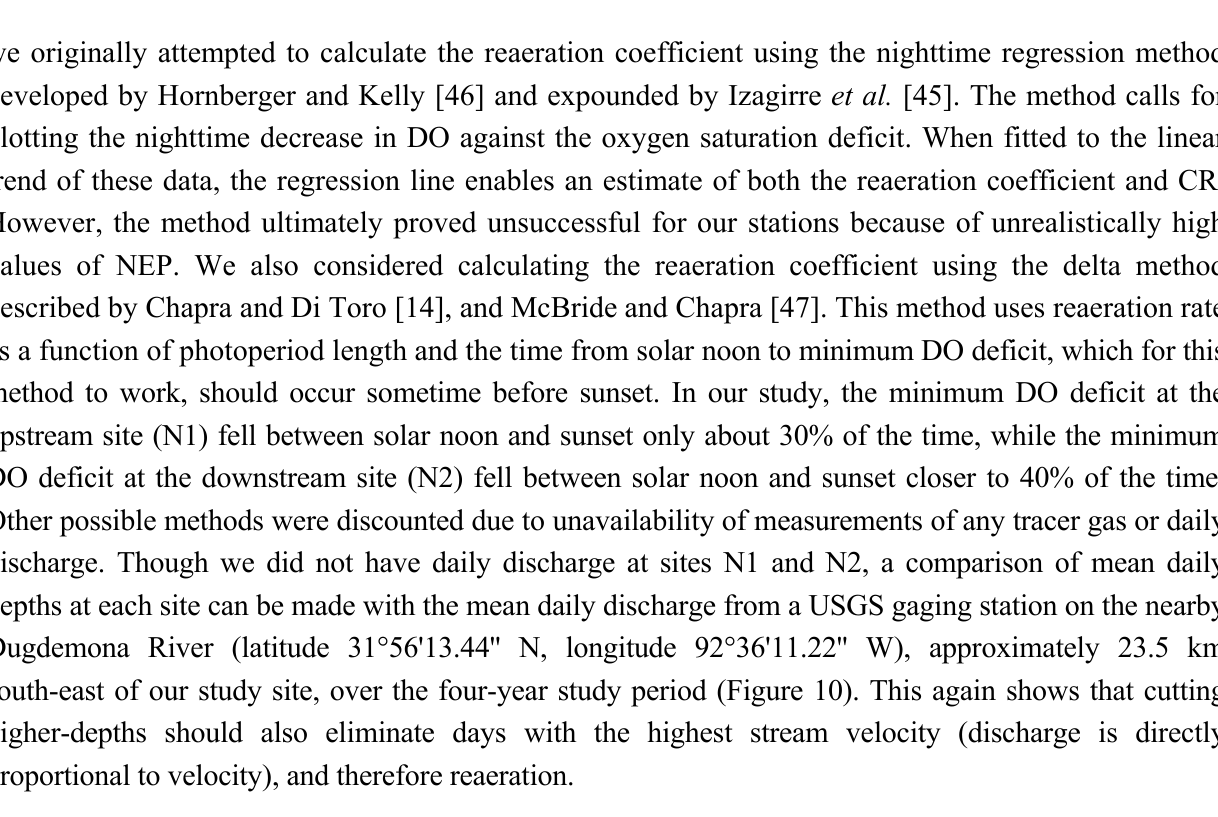
Figure 10. Time series of mean daily discharge (m 3 s − 1 ) at the Dugdemona River USGS gaging station (approximately 23.5 km south-east of our study site; latitude 31°56'13.44'' N, longitude 92°36'11.22'' W), along with mean daily depths (m) at sites N1 and N2 from June 2006 to August